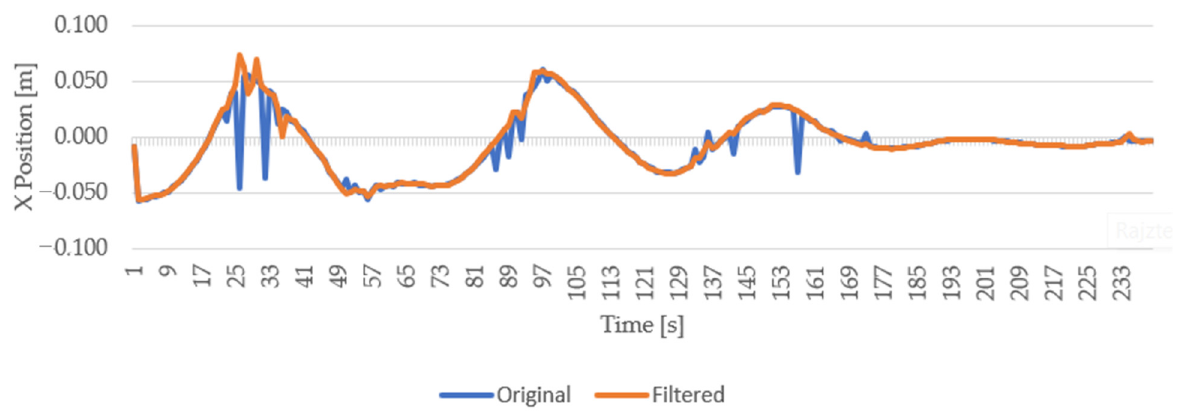
Figure 8. Example filtering